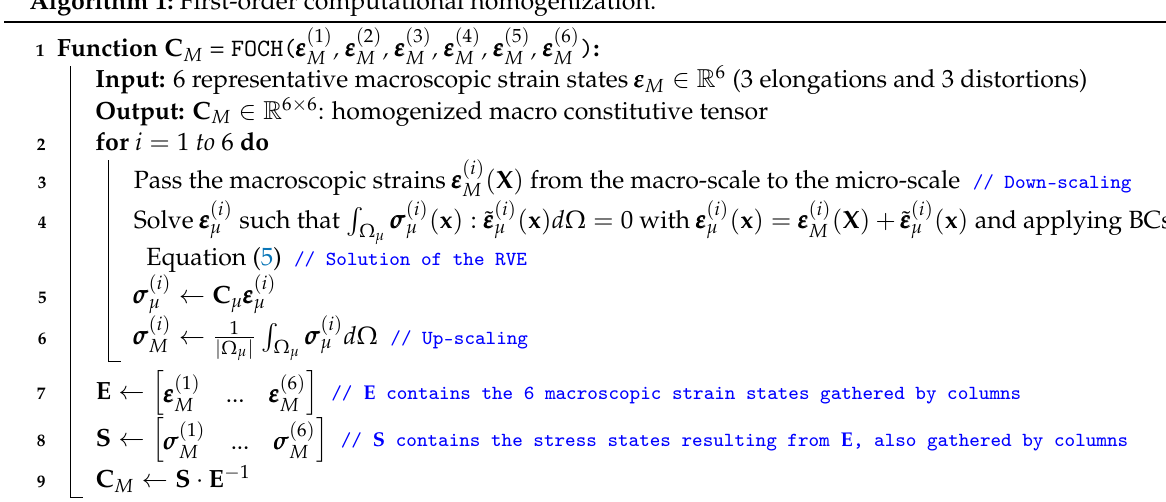
Algorithm 1: First-order computational homogenization.